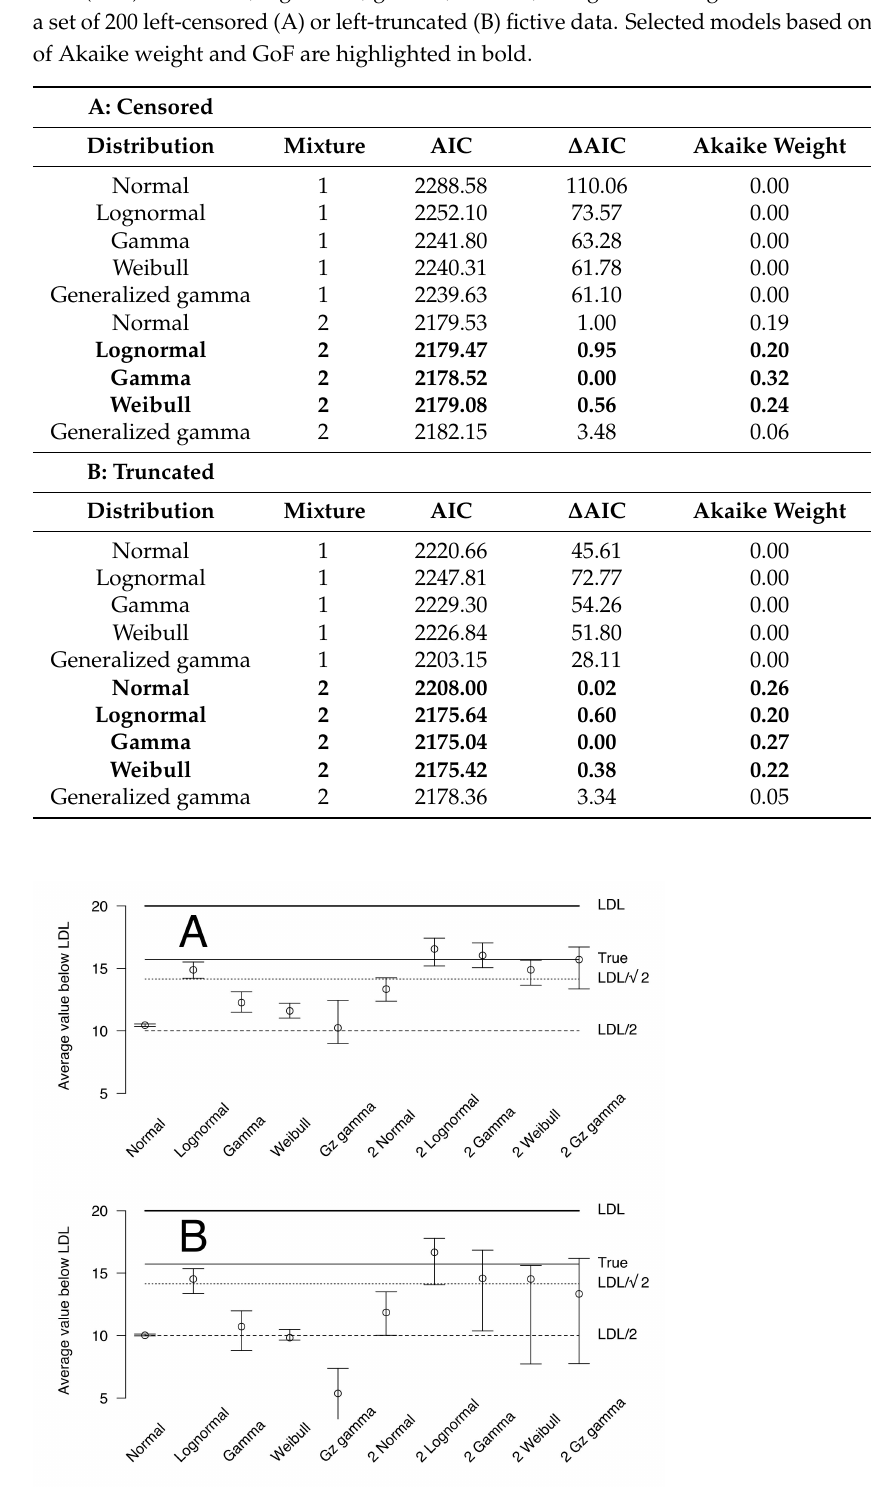
Figure 2. Average and 95% credible interval of the fitted values below the lower detection limit (LDL) for the censored ( A ) and truncated ( B ) fictive distributions. The models are shown on the x-axis , and the corresponding fitted values are shown on the y-axis . The true value based on the distribution used to generate the data is shown on the right, along with the usual LDL /2 and LDL / used for the